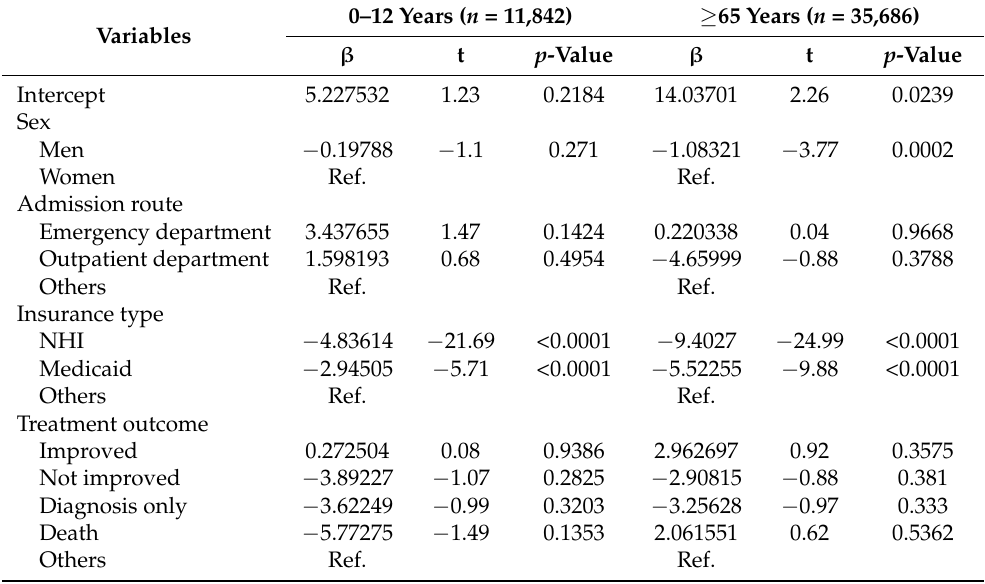
Table 6. Factors associated with length of stay in the children and elderly patients with